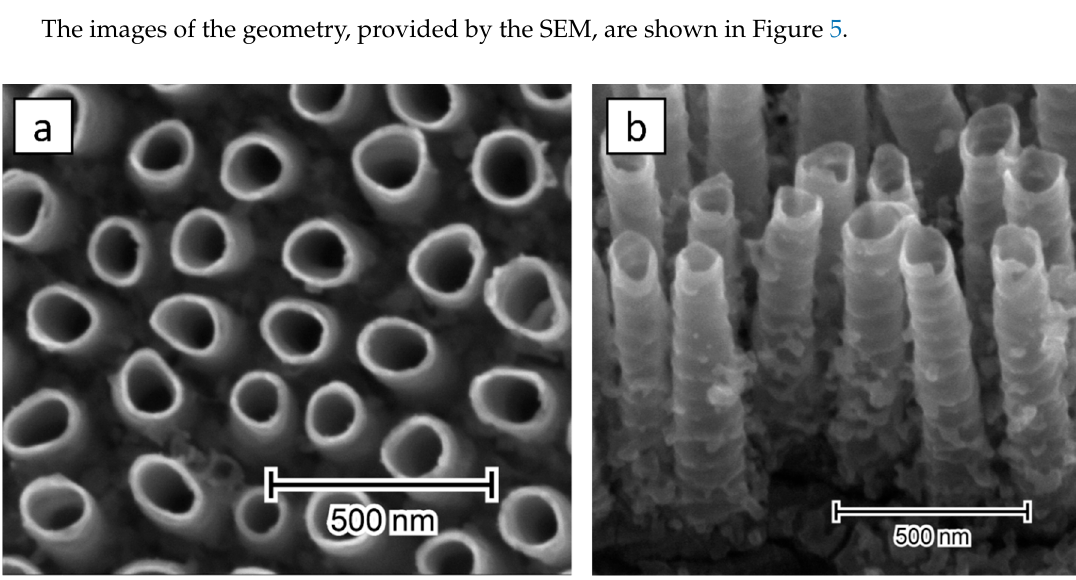
Figure 5. ( a ) Top and ( b ) side SEM image of the TiO 2 nanotubes after ultrasonic-treatment in a nickel